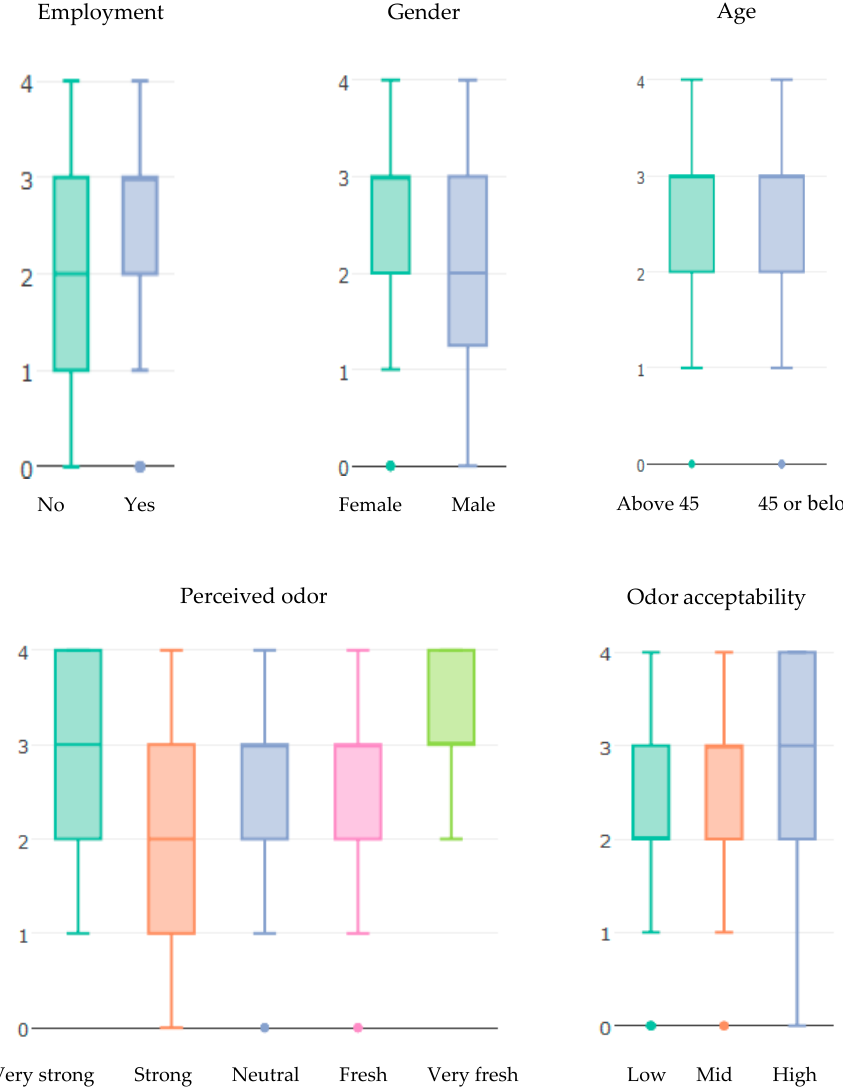
Figure 2. The effect of employment, gender, age, perceived odor, and odor acceptability on one subjective well-being (SWB) measure: satisfaction with how life turned out. Y -axis is the score of satisfaction with how life turned out, where 4 indicates the highest level of satisfaction and 0 indicates the lowest level of satisfaction.